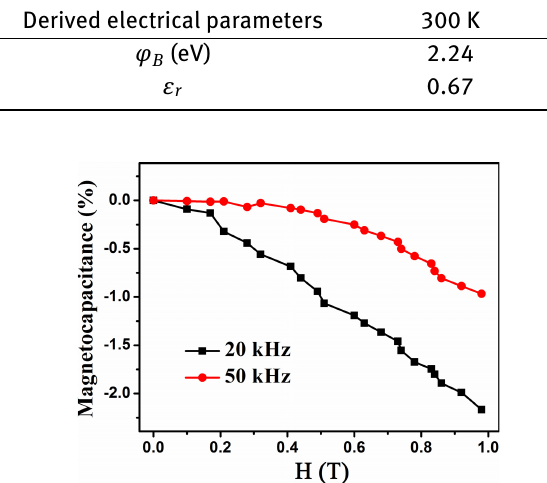
Figure 9: Magnetocapacitance of the sample with the applied mag- netic field at rom temperature at selective frequencies.